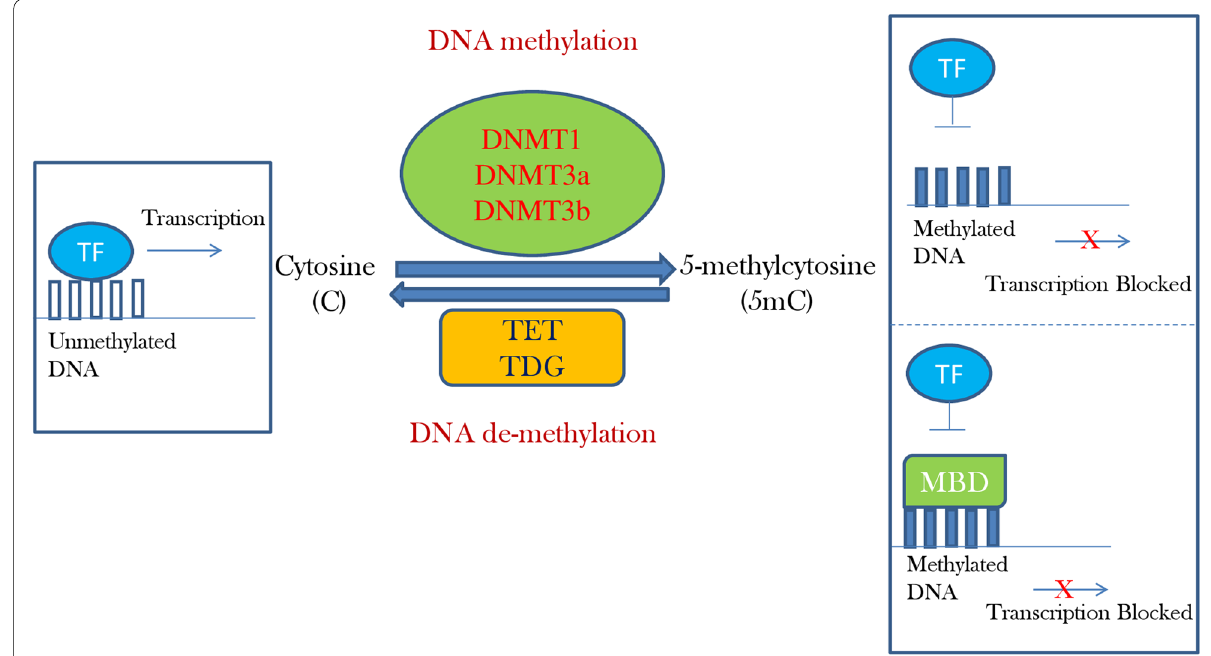
Fig. 3 Role of DNA methylation on gene